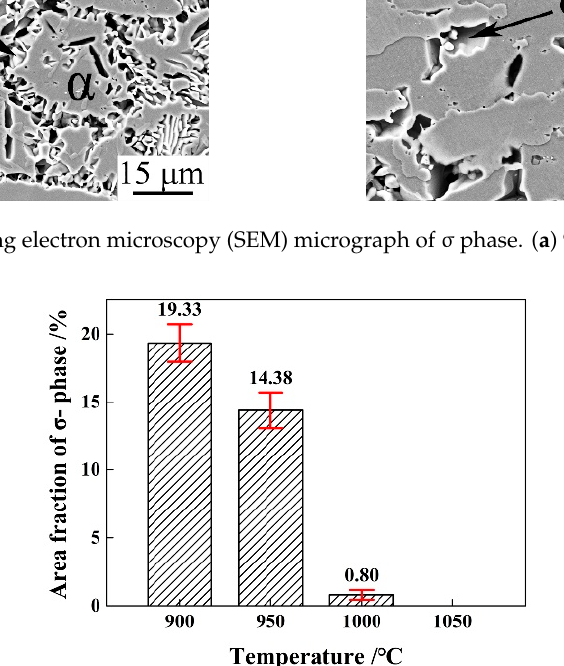
Figure 9. Area fraction of σ phase at different solution treatment temperatures (error bars represent standard deviation).